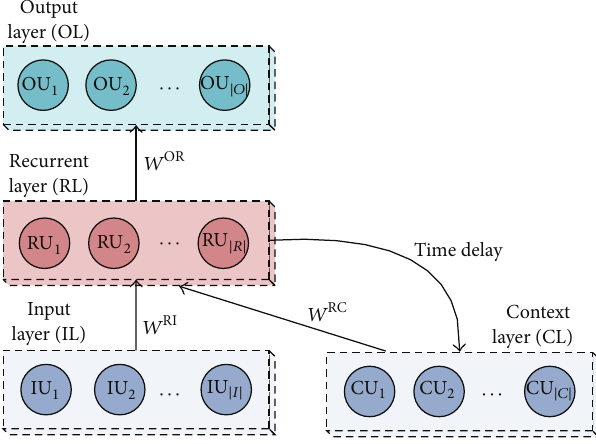
Figure 4: Architecture of SRNN.